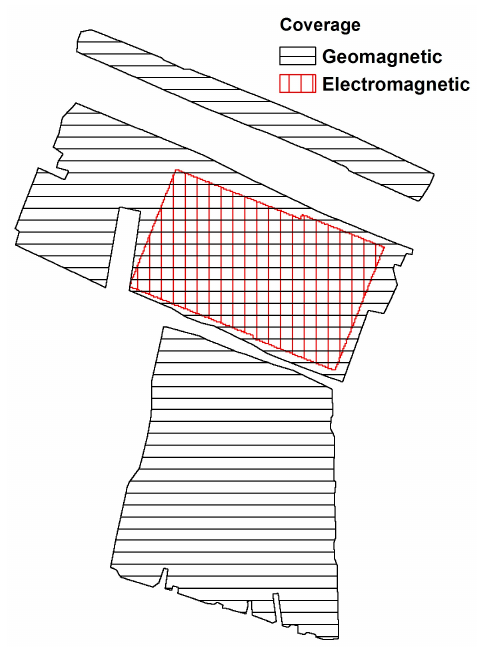
Figure 12. The overlay for the prospection coverage by different methods at Karatsantagli.